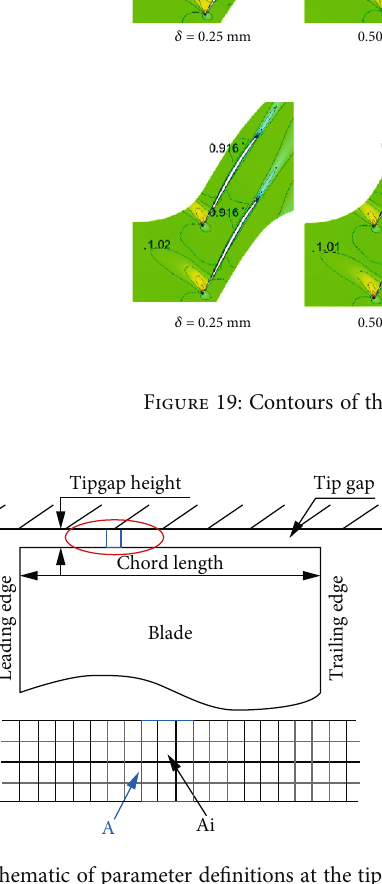
Figure 22: Pressure di ff erences between the pressure and suction sides of the clearances along the chords at a tip clearance of 0.25mm.